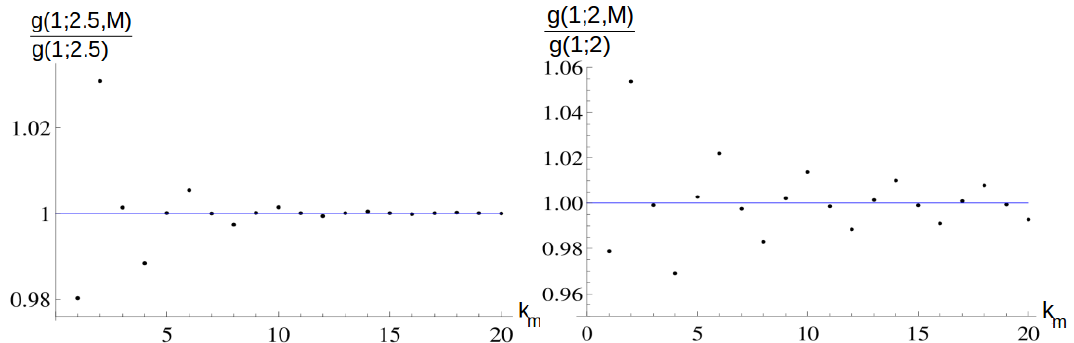
Figure 14: Dimensionless ratio g ( 1; α , M ) / g ( 1; α ) of the approximate analytical solution and the numerically exact solution of Eq. (4) for several values of the maximal order of expansion k , at dimensionless parameters α = 2.5 ↔ γ = 6.0257 (left panel) and α = 2 ↔ γ m (right panel). The ratio 1 corresponds to the exact solution and is indicated by the blue line as a guide to the eye. When α is decreased, larger values of the parameter M , or equivalently ( ≤ 2 M + 2 ) , are needed to reach a given accuracy. Quite remarkably, due to the oscillation k m of the analytics around the exact solution, odd-order terms are more accurate than even